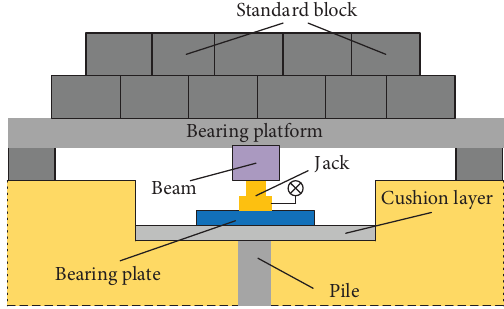
Figure 7: Schematic diagram of reaction force stacking method.